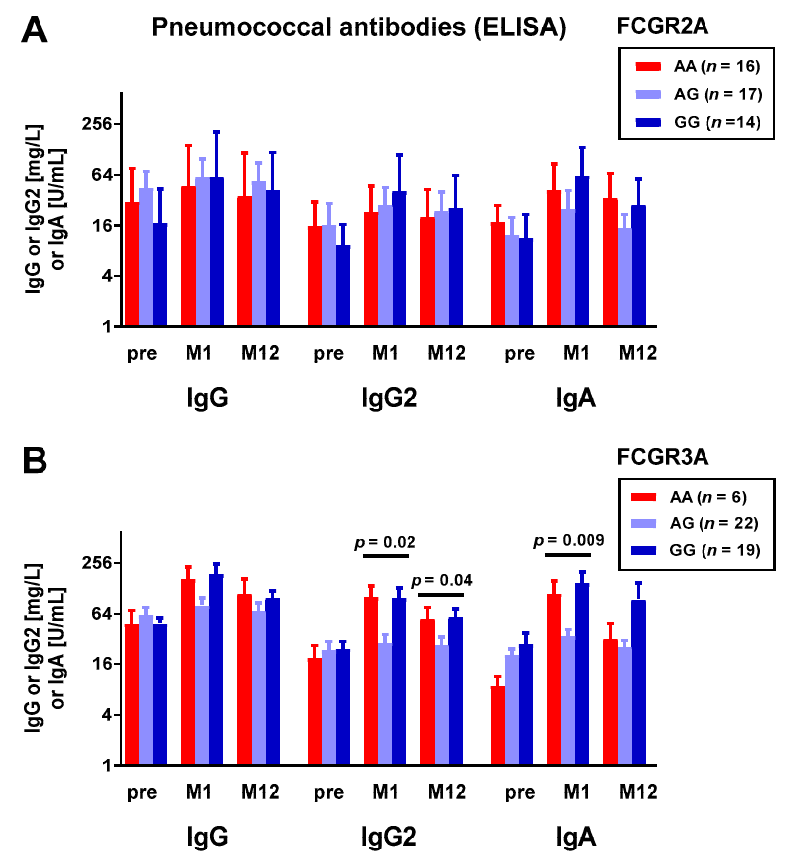
Figure 1. Kidney transplant recipients were genotyped for the polymorphisms FCGR2A rs1801274 ( A ) and FCGR3A rs396991 ( B ). IgG, IgG2, and IgA antibodies determined by commercial ELISA (VaccZyme™) prior to pneumococcal vaccination (pre) and at month 1 (M1) and month 12 (M12) thereafter were grouped by genotype. Antibodies are shown on a logarithmic scale (log2) as geometric means and geometric standard deviation factors [39]. The three groups were compared by Kruskal–Wallis test with Dunn’s multiple comparisons test. Of note, none of the results remained significant after Bonferroni